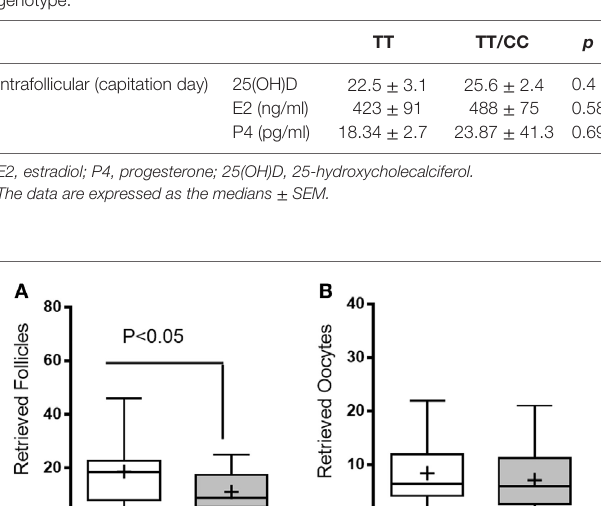
TaBle 6 | Intrafollicular 25(OH)D, E2 and P4 concentrations according to TaqI genotype.